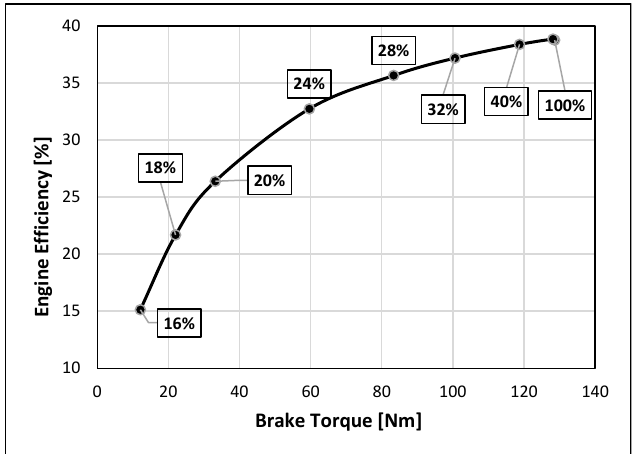
Figure 5. Engine efficiency as a function of engine torque for different throttle opening values.